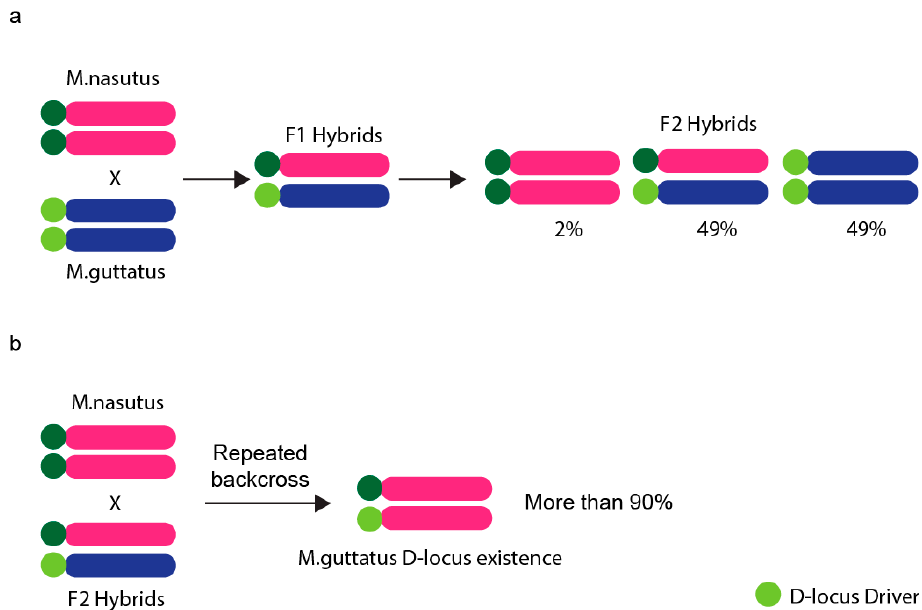
Figure 4. Biased chromosome transmission in hybrid Monkeyflowers. ( a ) F 2 hybrid Monkeyflower crosses of Mimulus nasutus (maternal; dd) and Mimulus guttatus (paternal; DD) were used to examine the chromosome transmission rate. The chromosome from M. guttatus with D-locus is preferentially transmitted to the next generation. ( b ) Female F 2 hybrids were repeatedly backcrossed with male M. nasutus and the genome was purified to the homozygous state for M. nasutus alleles after several recombination events. However, over 90% of D-locus from M. guttatus remained in the offspring.